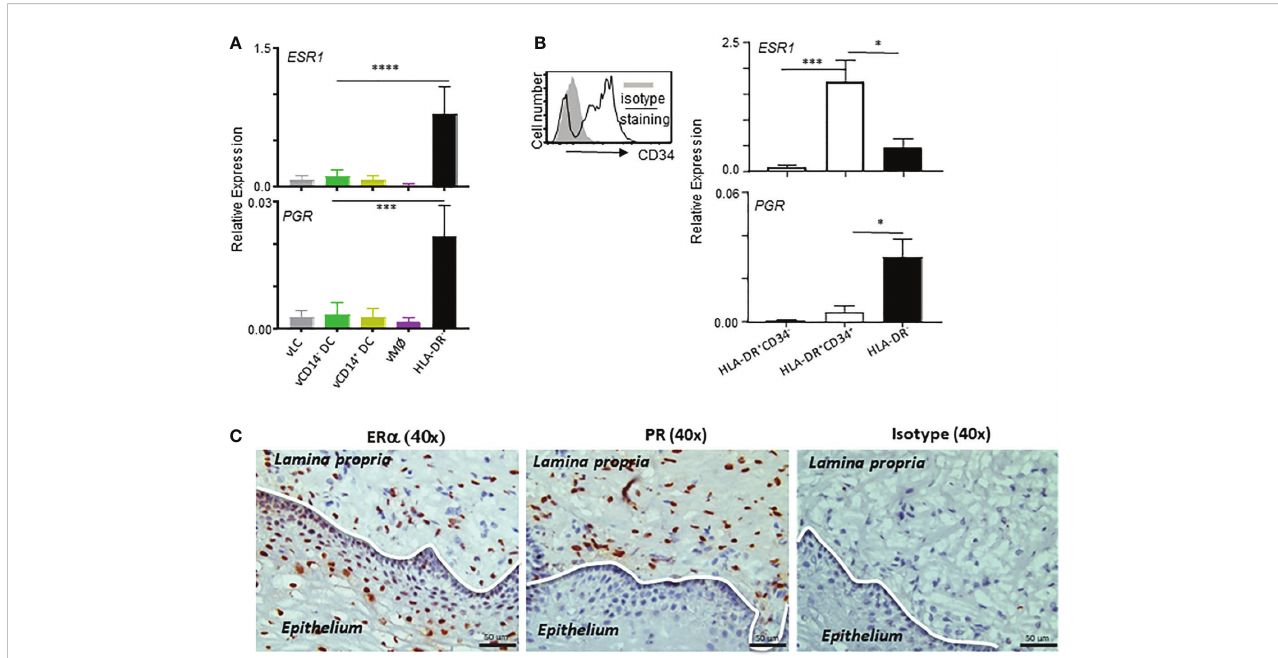
FIGURE 3 ESR1 and PGR are expressed mainly by HLA-DR + CD34 + and HLA-DR - cells, respectively, in the vaginal tissues. (A, B) qPCR analyses for ESR1 and PGR expression (normalized to B2M expression levels) in indicated cell types. Samples tested in this experiment were collected from tissues from 9 donors (ages: 28, 32, 41, 58, 59, 64, 65, 72, and 75-year-old) were tested. Cells were stained and FACS-sorted as illustrated in Supplementary Figure 1. Data are presented with mean ± SD. Statistical analyses were performed with One-way ANOVA. n.s.: not signi fi cant, *p < 0.05, ***p < 0.005, ****p < 0.001. (C) Estrogen receptor alpha (ER a ) and progesterone receptor (PR) expression in the human vaginal mucosal (VM) tissues. Immunohistochemical staining (x40) of frozen VM tissues with anti-ER a , anti-PR, and isotype control antibodies. Data are representative of experiments performed with tissues from 10 different